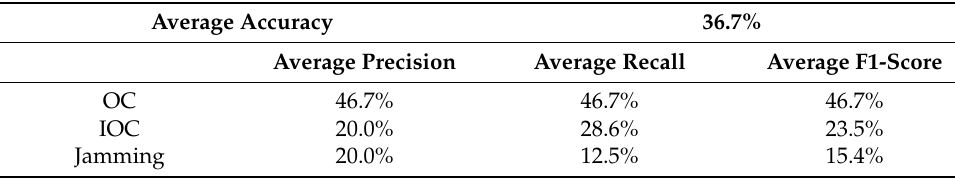
Table 12. k-NN Multivariate Performance.